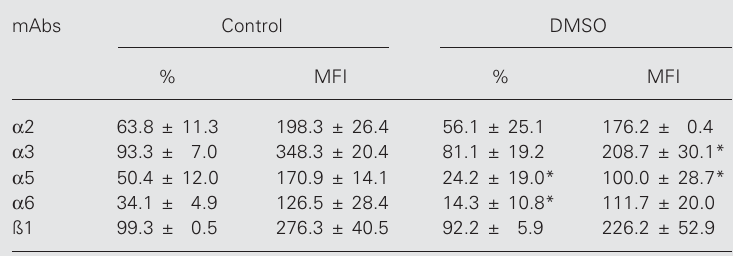
Figure 2. Time course of integrin expression and percent cells in G0/G1 during dimethyl sulfoxide (DMSO) treatment of LISP-1. Control cells (filled bars) and DMSO-treated cells (open bars) indicate the variation of mean fluorescence intensity (MFI) (A) and the percent of positive cells for α 5 (B) and α 6 (C) integrin (left y-axis). The per- cent of G0/G1 fraction (right y- axis) is represented for control cells and DMSO-treated cells. Data are the mean ± SD ob- tained for 5 independent experi- ments. *P < 0.05 compared to control (ANOVA).